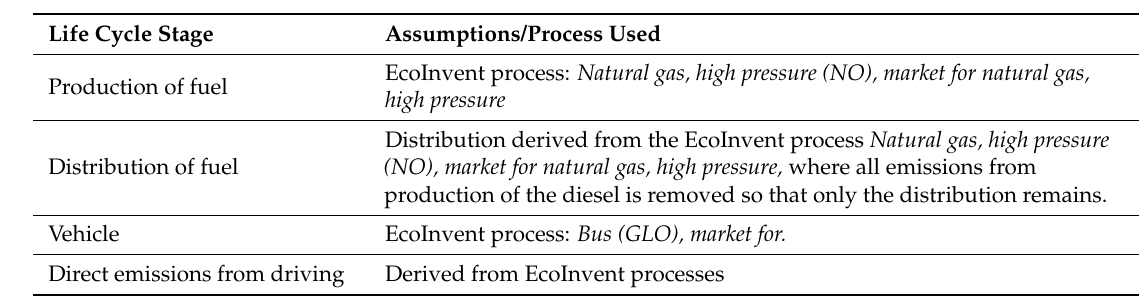
Table A3. Natural gas.